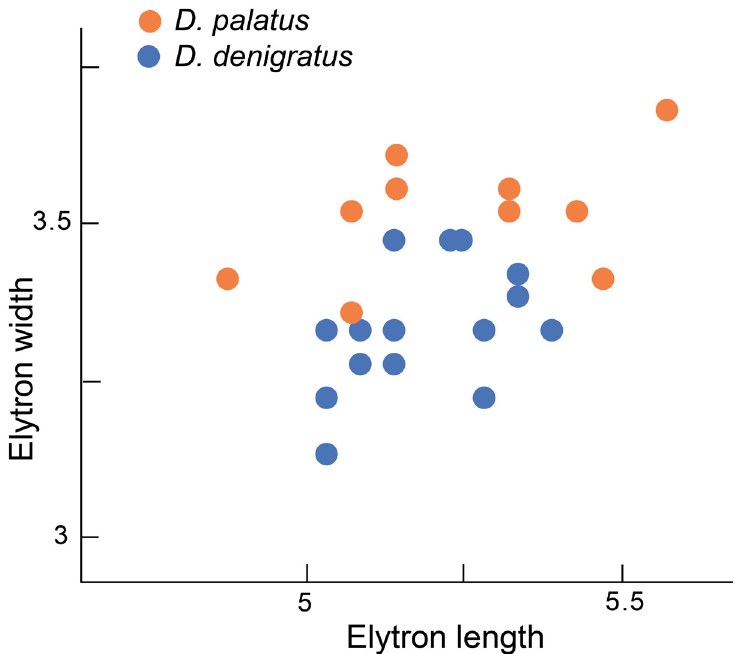
Fig. 51. Compared dimensions of the elytra of Dyscolus denigratus (Bates, 1891) and D. palatus Moret,